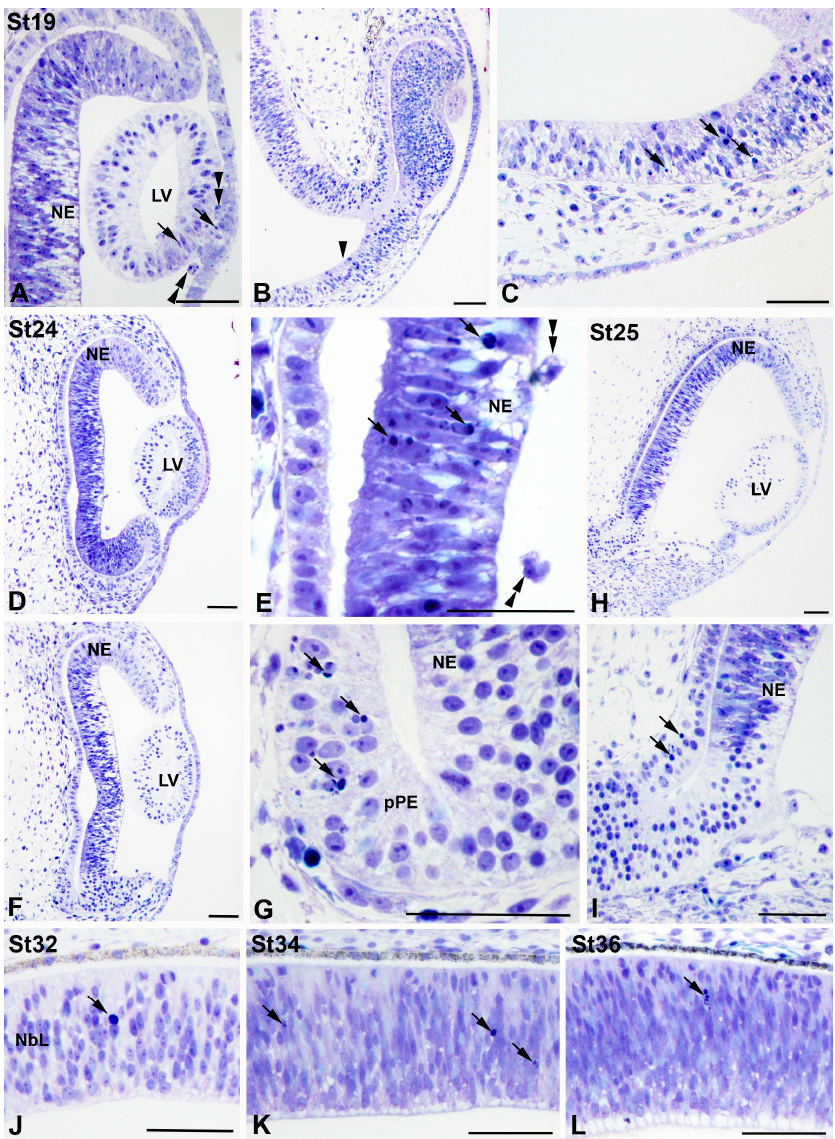
Figure 4. Pyknotic bodies during visual system development in T. guttata . Toluidine blue-stained semi-thin sections were obtained from the heads of embryos at different stages of development. At E19, pyknotic fragments were mainly detected in the anterior wall of the lens vesicle (arrows in ( A )), but also in the SONCs (arrowhead in ( B ), arrows in ( C )). At St24 ( D – G ), pyknotic bodies were concentrated in retinal regions located dorsally to the optic nerve head (arrows in ( E )) and in the presumptive pigment epithelium located surrounding the optic nerve head (arrows in ( G )). At St25 ( H , I ), abundant pyknotic fragments were detected in the dorsal region of the distal optic nerve (arrows in ( I )). Pyknotic bodies were sparse and dispersed throughout the neuroblastic layer (NbL) by St32 (arrow in ( J )), St34 (arrows in ( K )), and St 36 (arrow in ( L )). Abbreviations: LV, lens vesicle; NbL, neuroblastic layer; NE, neuroepithelium; pRPE, pre- sumptive retinal pigment epithelium. Scale bars: 50 µm.